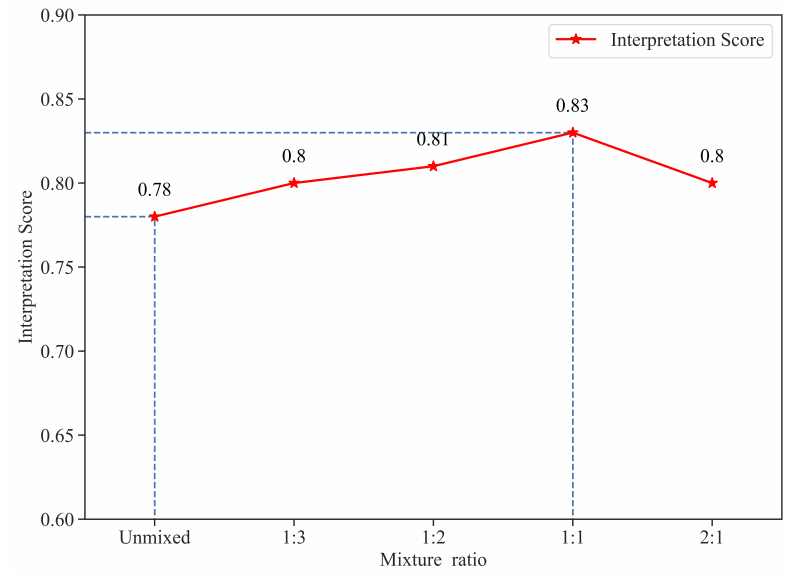
Figure 15. Diagram of the change of “Interpretation Score” with mixture